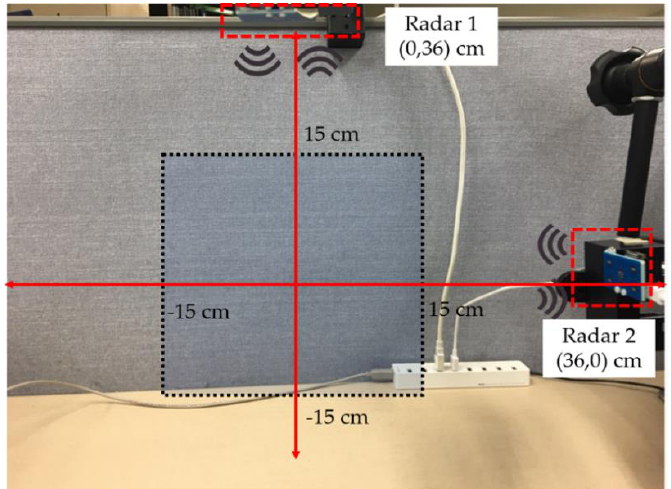
Figure 10. Experimental setup for data acquisition comprised of two radars operating in a mono-static configuration.